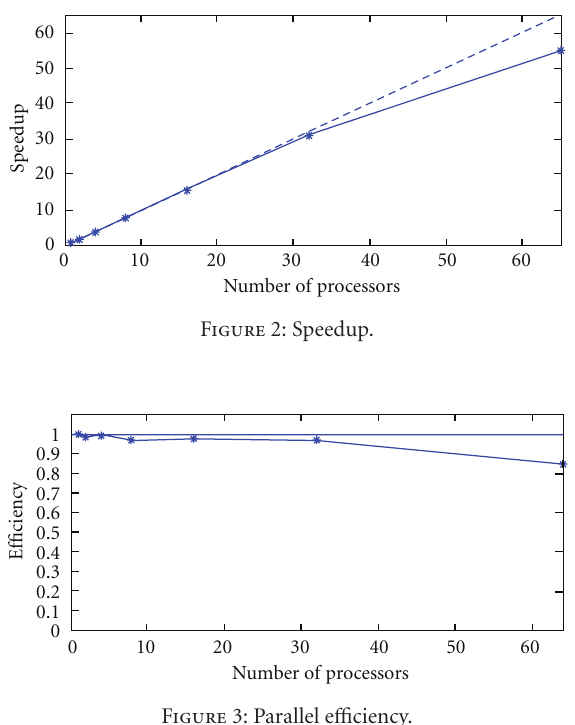
Figure 3: Parallel e ffi